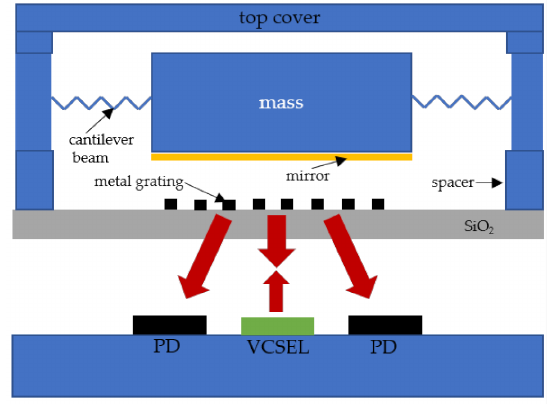
Figure 11. Schematic diagram of the internal structure of the